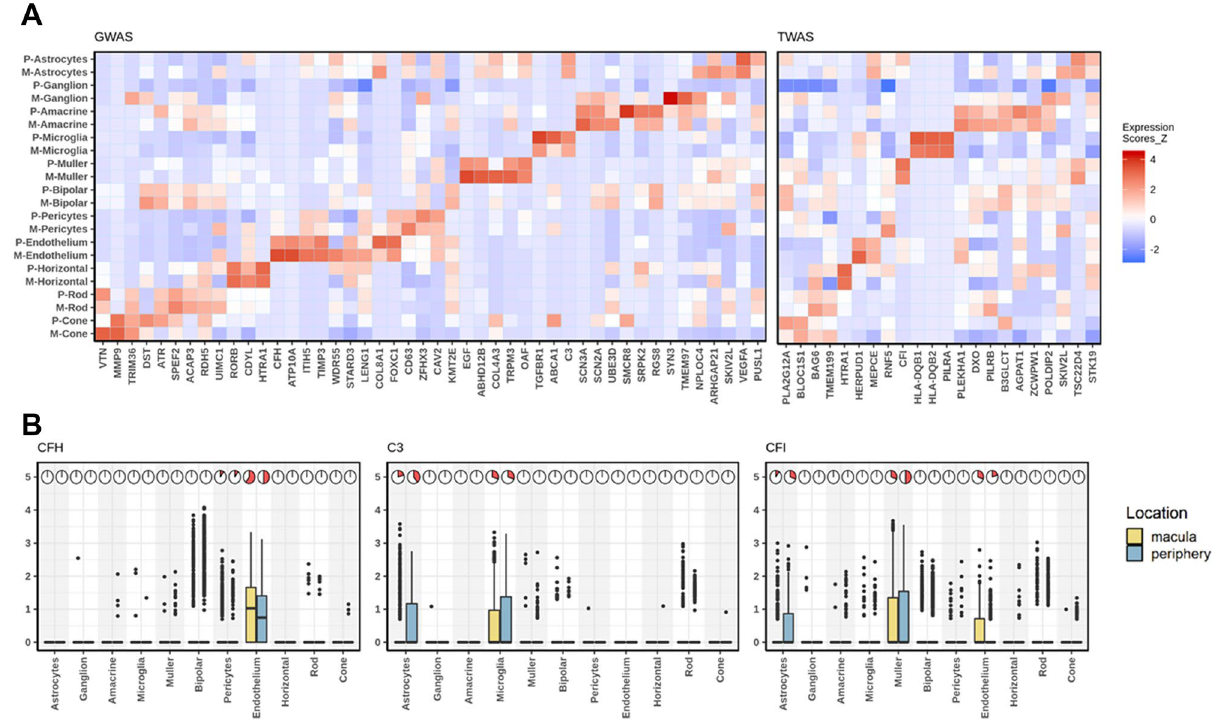
Figure 3. Cell type- and region-specificity of AMD risk genes. ( A ) Heatmap showing expression levels of AMD risk genes by cell type. Color in the heatmap represents expression intensity with red signifying higher expression in units of z-score. Left panel: AMD associated genes identified by loss- or gain-of-function mutations or by GWAS 3 . Right panel: target genes based on TWAS analysis listed 34 .Three AMD risk genes in the complement pathway, CFH , C3 and CFI , were highlighted. ( B ) boxplot shows expression level of CFH , C3 and CFI across cell types and retina regions. The pie chart show the percentage of cells expressing the gene in a particular region and cell